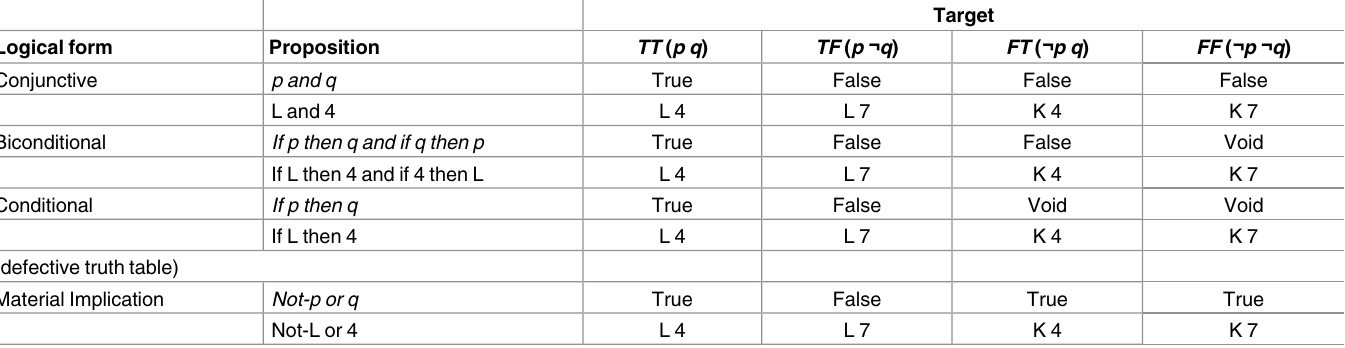
Table 1. Truth Table for the Four Logical Forms (Conjunctive, Biconditional, Conditional, Material Implication) and Examples of